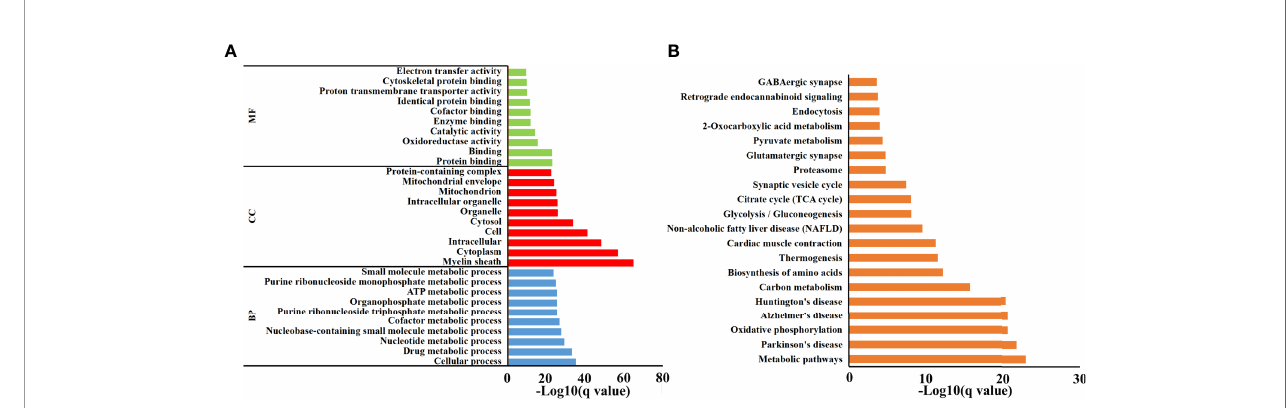
FIGURE 3 | Functional analyses of precursor proteins. (A) Gene ontology (GO) analysis. Enriched terms are grouped by GO category biological process (BP), molecular function (MF) and cell component (CC). (B) The top 20 signi fi cantly enriched